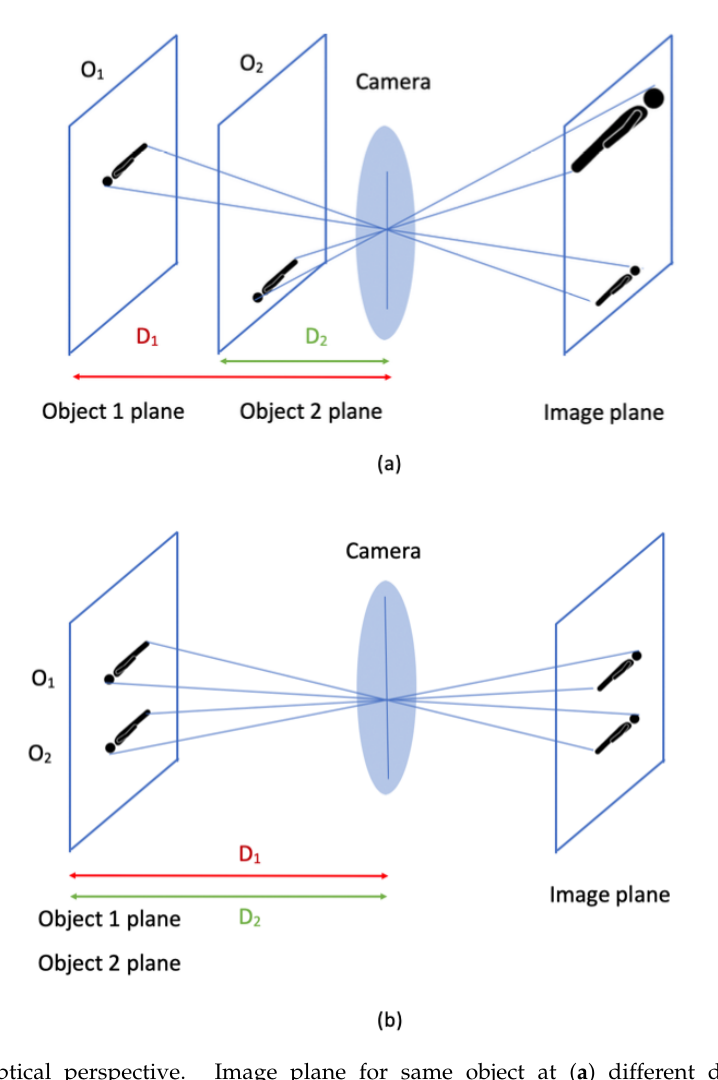
Figure 5. Optical perspective. Image plane for same object at ( a ) different distances and ( b ) different heights.